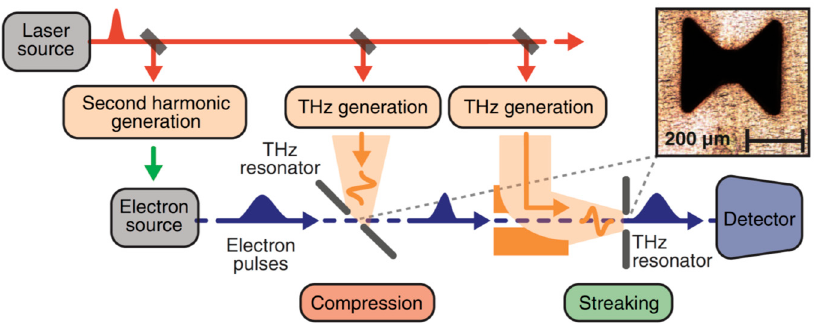
Figure 20. All-optical control and metrology of electron pulses. Experimental setup: a 1-ps laser pulse from a Yb:YAG regenerative amplifier is frequency doubled and generates an electron pulse from a thin-film gold photocathode. The laser also drives two optical-rectification stages, each generating single-cycle THz pulses with energy of up to 40 nJ. (Inset) THz resonator structures are laser-machined in a 30-mm-thick aluminum foil. The first element, used for compression, is oriented at 45 ◦ to the electron beam, providing time-dependent longitudinal forces on the electrons. The second THz resonator, used for streaking, is oriented normal to the beam, resulting in time-dependent transverse deflection. Figure adapted from Reference [245] with permission from Science